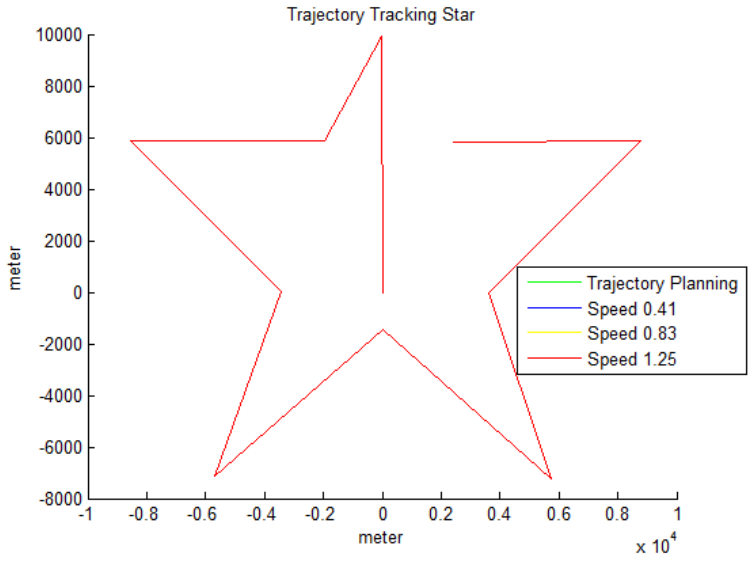
Figure 20. Trajectory tracking with star model.